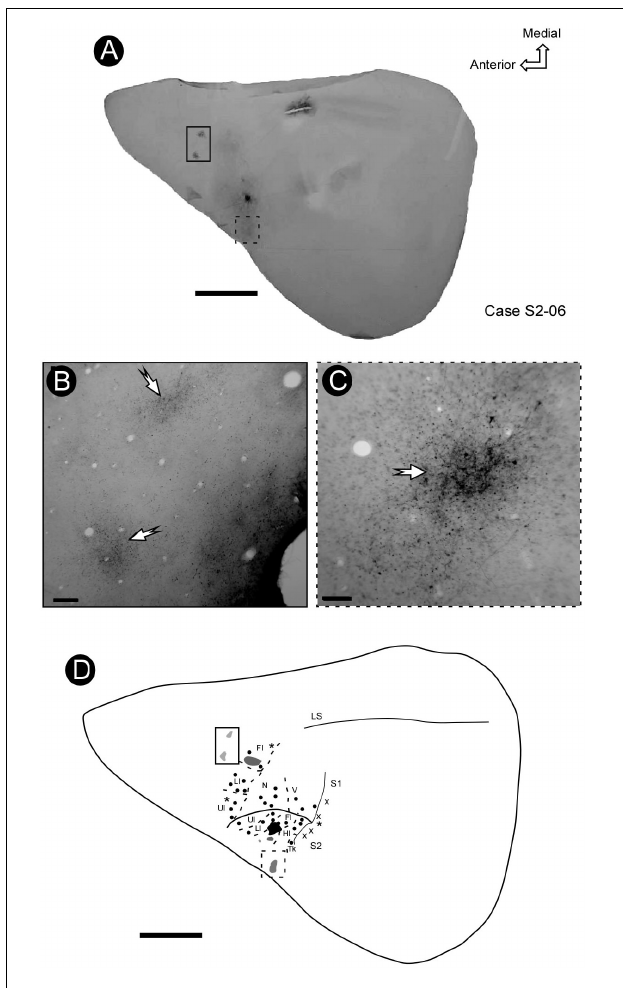
FIGURE 8 | The pattern of connectivity between S2 and S1. (A) BDA injection in the representation of the forelimb in S2 (arrow). (B,C) Micrograph amplification showing the foci of projection from the region of forelimb representation in S2 to the rostral part of S1 (solid rectangle) and lateral part of S2 (dashed rectangle), respectively (arrows). (D) Electrophysiological mapping of S1 and S2, focusing on the representation of the forelimb, showing the site of injection in S2 (black spot), its projection to S1 (gray spot) and some additional foci located in a rostral region of S1 and area PR. Scale bars: A,D : 5 mm; B,C : 500 µ m. LS, lateral